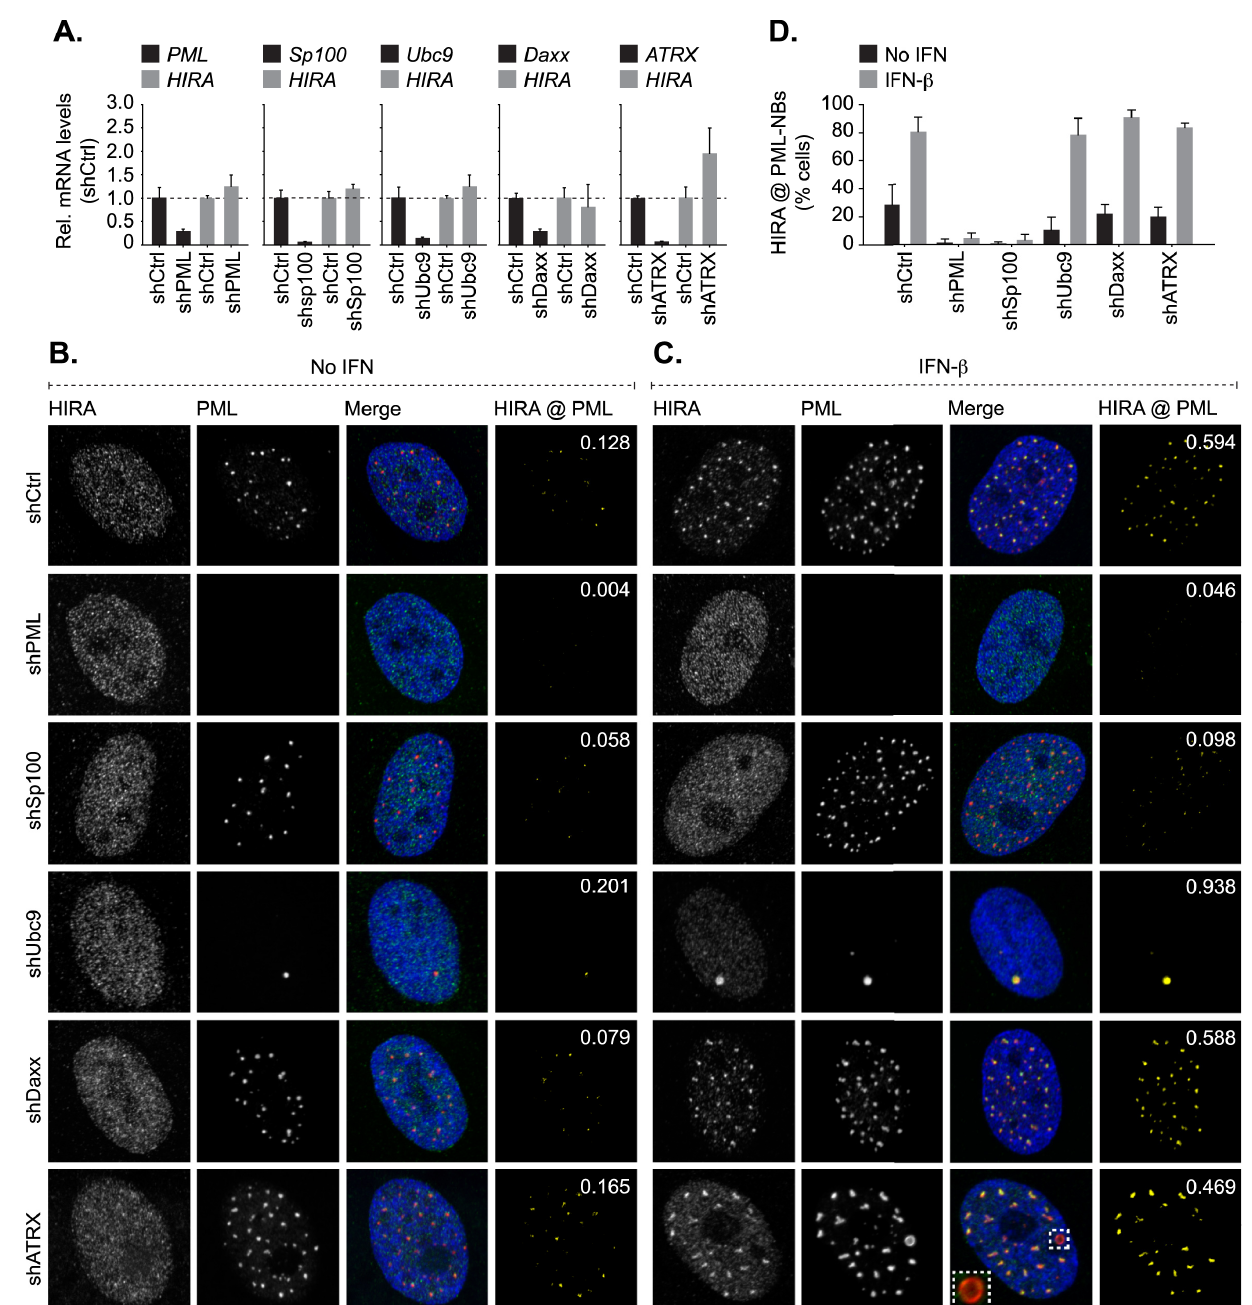
Fig 4. HIRA localization at PML-NBs in response to cytokine stimulation occurs in a PML and Sp100 dependent manner. HFt cells were stably transduced to express individual non-targeting control (shCtrl) or PML-, Sp100-, Ubc9-, Daxx-, or ATRX-targeting (shPML, shSp100, shUbc9, shDaxx, or shATRX, respectively) shRNAs. (A) qRT-PCR quantitation of PML , Sp100 , Ubc9 , Daxx , ATRX , or HIRA mRNA levels in stably depleted HFt cell lines (as indicated). Means (RQ) and SD (RQ min/max) shown and expressed relative to shCtrl cells. (B, C) Nuclear localization of HIRA (green) and PML (red) in shCtrl, shPML, shSp100, shUbc9, shDaxx, or shATRX cells mock treated or stimulated with IFN- β (100 IU/ml) for 24 h. Nuclei were stained with DAPI (blue). Inset shows magnified region of interest (dashed boxes). Cut mask (yellow) highlights regions of colocalization between HIRA and PML. Weighted colocalization coefficients shown. (D) Quantitation of the population of HFt cells positive for HIRA localization at PML-NBs (as in B). n � 300 cells per sample population derived from four independent treatments. Means and SD shown.